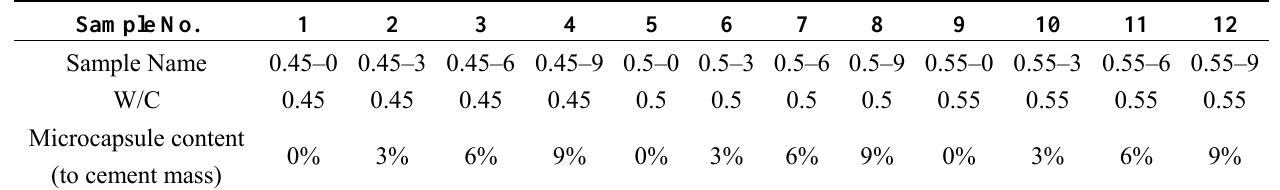
Table 1. Specimens for mechanical